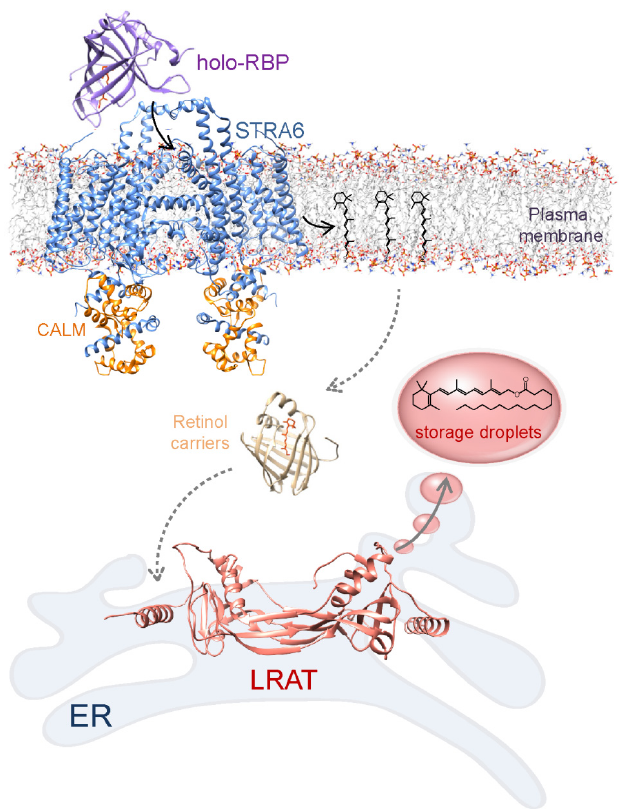
Figure 2. Schematic representation of STRA6-dependent vitamin A cellular uptake. Transport of all- trans -retinol carried by serum retinol-binding protein (RBP) across the plasma membrane is mediated by RBP receptor, STRA6. On the cytoplasmic side, vitamin A binds to retinol binding proteins. They might facilitate transport of retinol across the cytoplasm to the endoplasmic reticulum (ER), where it is esterified by action of lecithin:retinol acyltransferase (LRAT). LRAT acts independently in storing vitamin A and cellular retinol binding proteins are not absolutely essential for its activity. Because the factors that contribute to the transport of vitamin A across the cytoplasm are not fully understood this process is illustrated by dashed arrows. Structures of RBP and retinol binding protein (here cellular retinol-binding protein 1, CRBP1) correspond to PDB accession numbers 1RBP [78] and 5H8T [79], respectively. STRA6 refers to the cryo-electron microscopy structure of zebrafish protein in complex with calmodulin (EM Data Bank #8315) [75]. LRAT model was built base on the structure